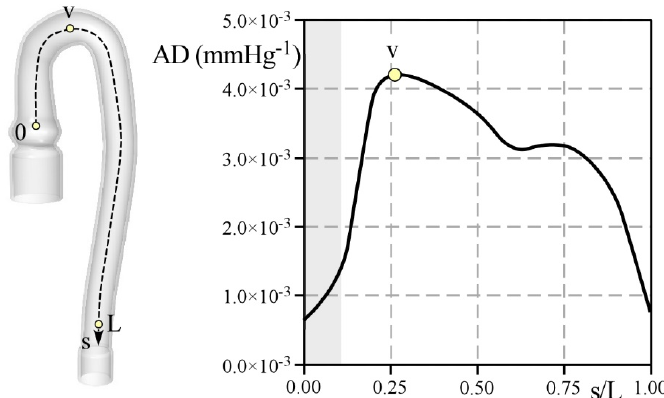
Figure 10. Aortic distensibility, AD, estimated along the normalized path line, s/L, according to Equation (1). Equation